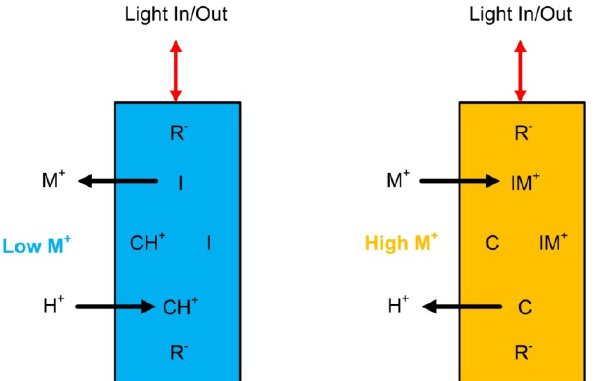
Figure 10. Summary of the ion-exchange sensing mechanism that forms the basis of bulk optrode functionality. When exposed to low analyte ion (M + ) activity the optrode membrane is one colour (left) while when exposed to high analyte ion activity the film undergoes a change in its optical properties and appears a different colour (right). This colour change is typically sensed through an attached spectrometer. The ion-exchange mechanism involves the exchange of the analyte ion and the hydrogen ion into and out of the film; C = chromoionophore, I = ionophore, R − = anionic site, IM + = ionophore-analyte ion complex, CH + = chromoionophore-hydrogen ion